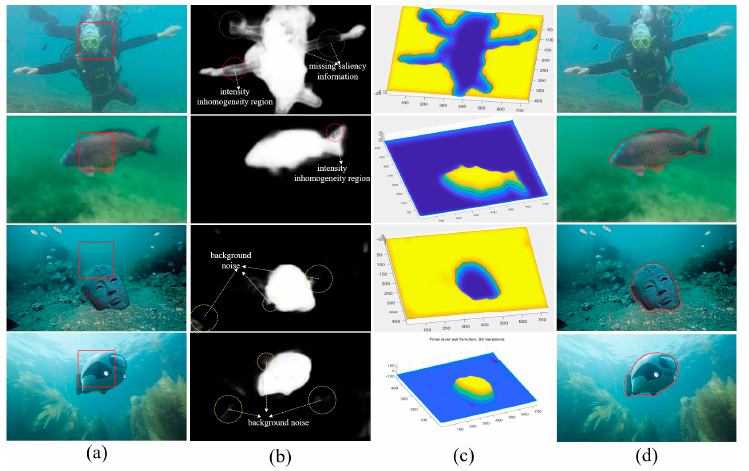
Figure 4. The salient object segmentation results of the proposed model. ( a ) Original underwater images with an initial zero level contour. ( b ) Saliency images ( c ) Final level set function. ( d ) The results of our method.